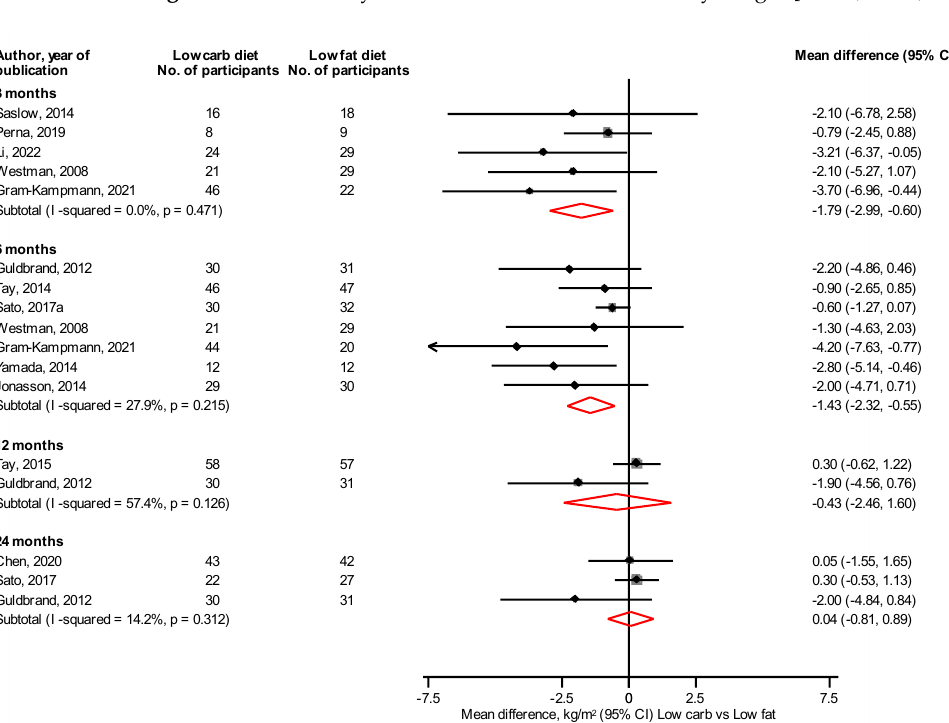
Figure 6. Low carbohydrate versus low fat diet and waist circumference [31,35,38,41,48,50,52 – 54].